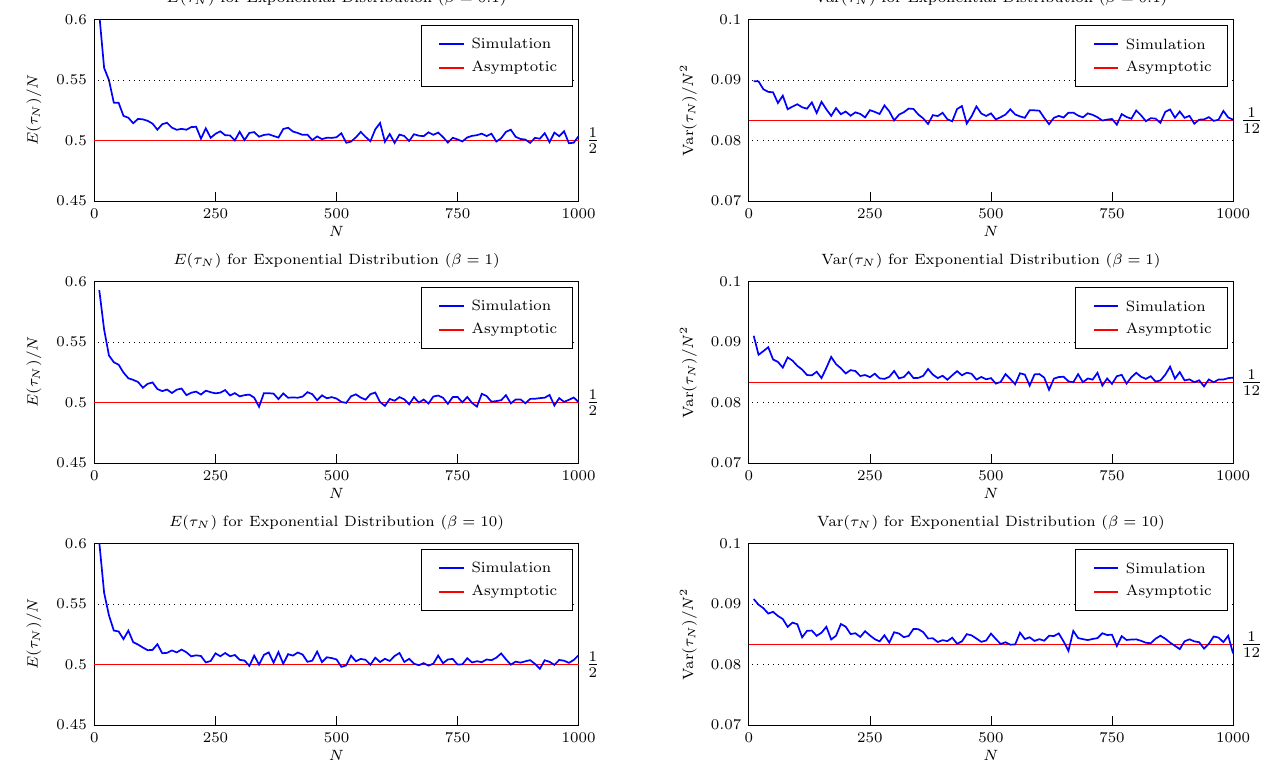
Figure 3. Comparison of large- N asymptotic predictions for the expectation and variance of the optimal stopping rule for the exponential distribution with a range of parameter values. In each case, the behaviour tended to the same value in the large- N limit, validating the conclusion that the leading-order asymptotics of statistical properties of optimal stopping do not depend on the distribution parameters for distributions with exponential upper tails. This is in contrast with the Pareto distribution, seen in Figure 1, which has algebraic upper tails; in this case, the asymptotic values changed as the parameters were